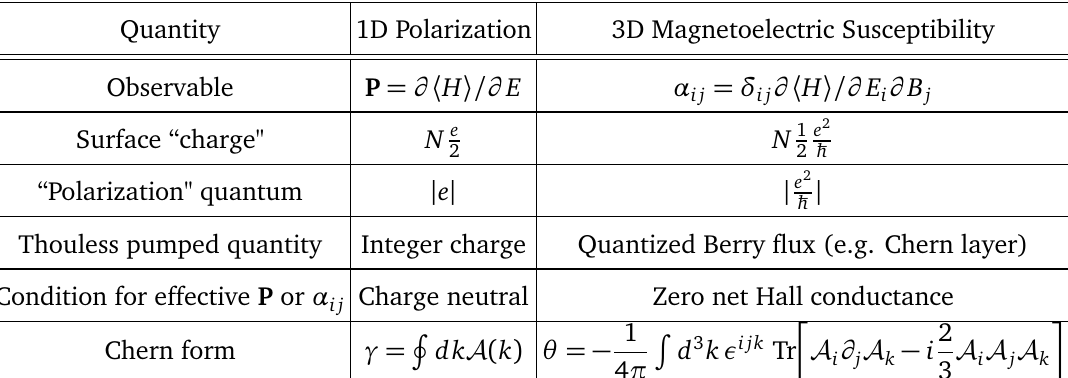
Table 1: Analogies between polarization and magnetoelectric susceptibility in in- version symmetric systems. For both cases presented here for inversion symmetric systems, N is an even integer in trivial materials and is an odd integer in topological systems. Based in part on Ref. [ 72 ] . Note that both Chern forms can be expressed as